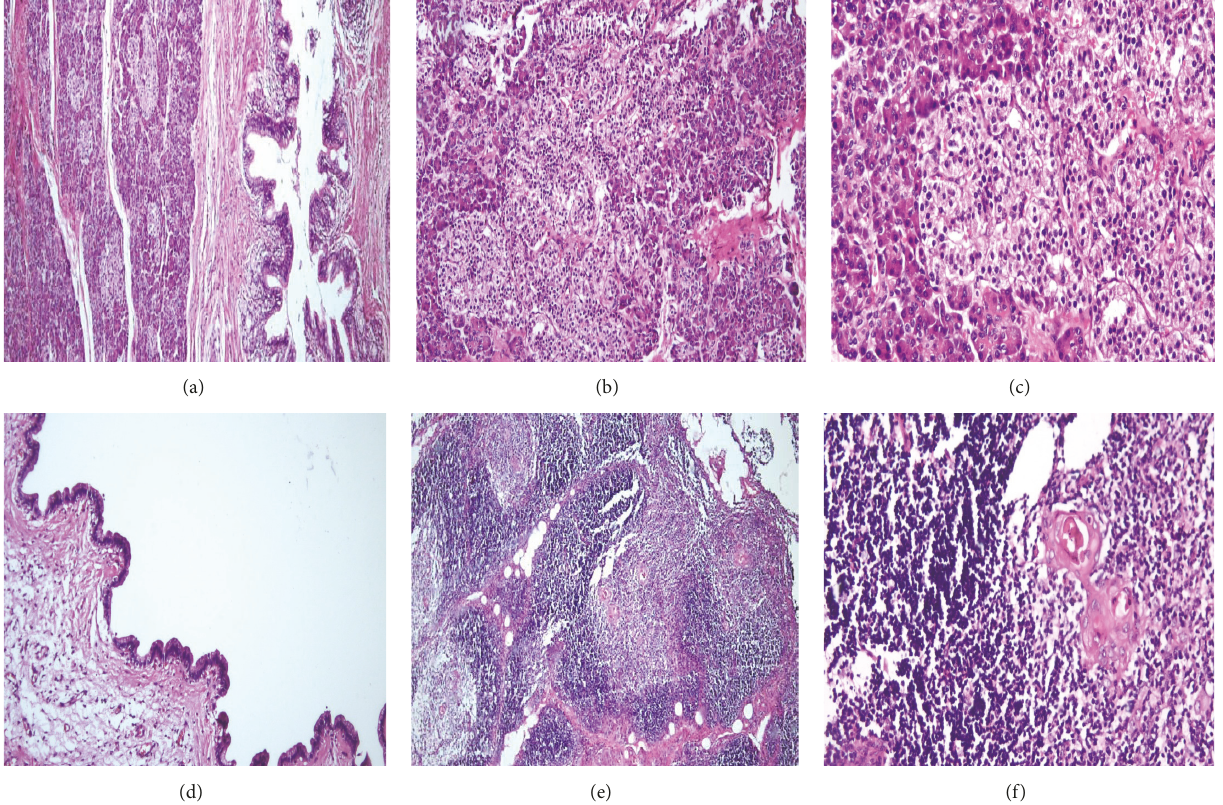
Figure 2: (a) An Island of pancreas tissue bordered by thick fibrous tissue with pancreatic interlobular duct around it (H&E-4x). (b) Pancreas tissue consists of exocrine gland with eosinophilic granular cytoplasm and endocrine cells (Islets of Langerhans) (H&E-10x). (c) Increase in the endocrine portion (Islets of Langerhans) of pancreatic tissue (H&E-40x). (d) Mediastinal cyst lined by simple cuboid and columnar epithelium(H&E-10x).(e)Hyperplasiaofthymicglandwasobserved(HE-4x).(f)NormalappearanceoflymphocytesandHassall’scorpuscles